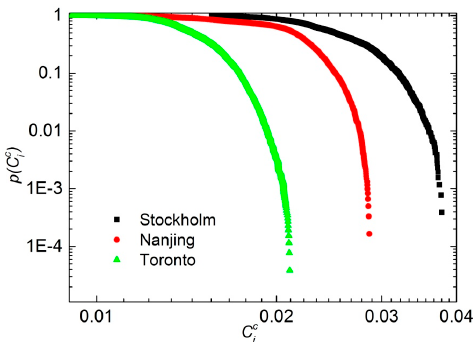
Figure 5. Cumulative probability distributions of closeness centrality of: Stockholm, Nanjing and Toronto. ISPRS Int. J. Geo-Inf. 2017 , 6 , 295